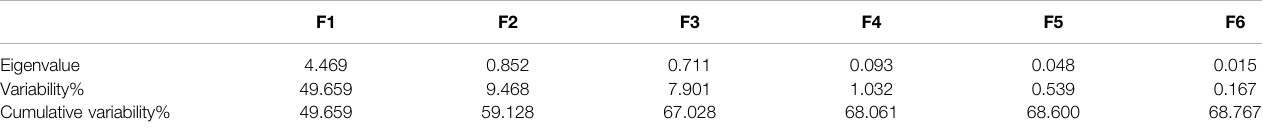
TABLE5| Eigenvalue,variability,andcumulativevariabilityexplainedbyfactoranalysis(6factors)usingcorrelationmatrixonthemeasuredattributes.TheeigenvalueofF1is 4.469, whereas the eigenvalues of the other factors are all less than 1. The cumulative fi rst three factors account for almost 67% of the total variation. This shows that these three factors de fi ne the most variability and can be used as replacements for other factors. F1